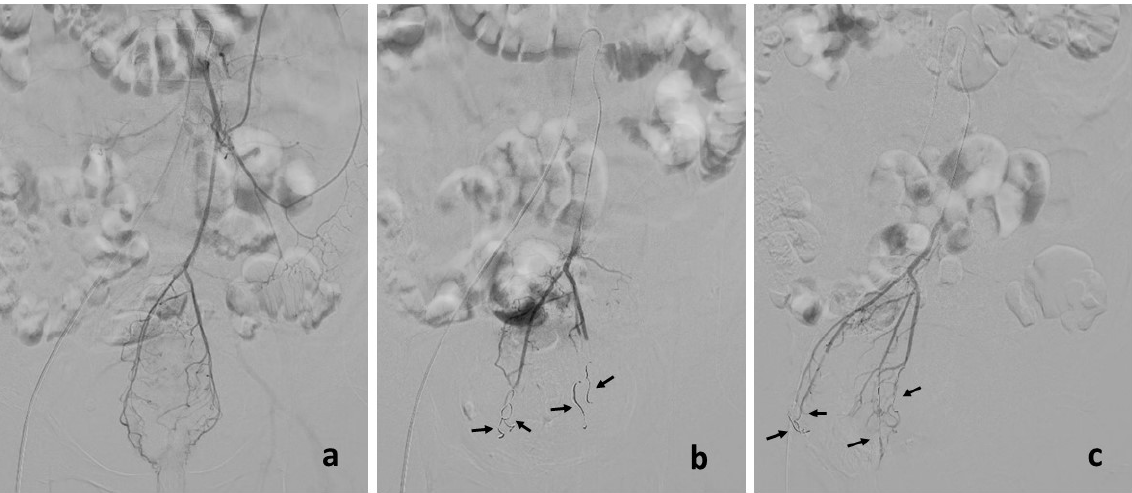
Figure 1. Diagnostic phase with hemorrhoidal arteries evaluation ( a ). Four Interlock and IDC coils (arrows) were positioned in the distal branches of the superior hemorrhoidal arteries (( b ) = antero ‐ posterior radiographic view; ( c ) = latero ‐ lateral radiographic view).